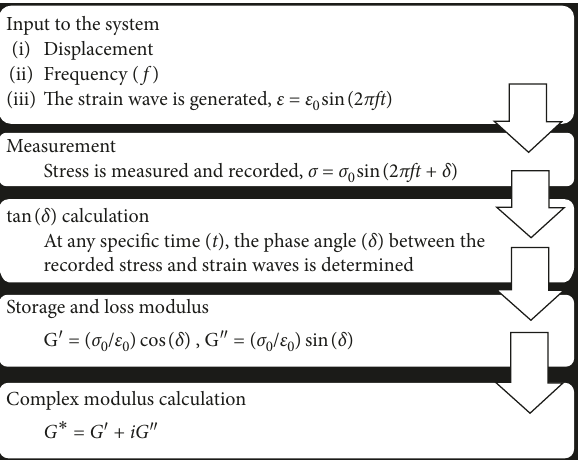
Figure 1: Algorithm of calculating mechanical properties of vis- coelastic materials in DMAs.